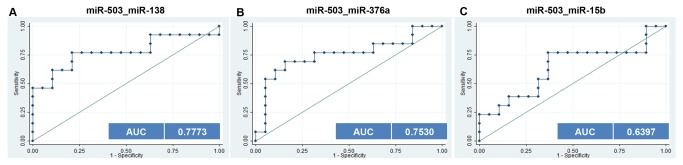
ROC curves to compare the ability of combinations of miRNAs to distinguish between DM2 and OB-DM2 groups.The combination of miR-503 and miR-138(A) and miR-503 and miR-376a (B) could distinguish DM2 from OB-DM2 patients. (C) The combination of miR-503 and miR-15b cannot distinguish between DM2 and OB-DM2 patients.